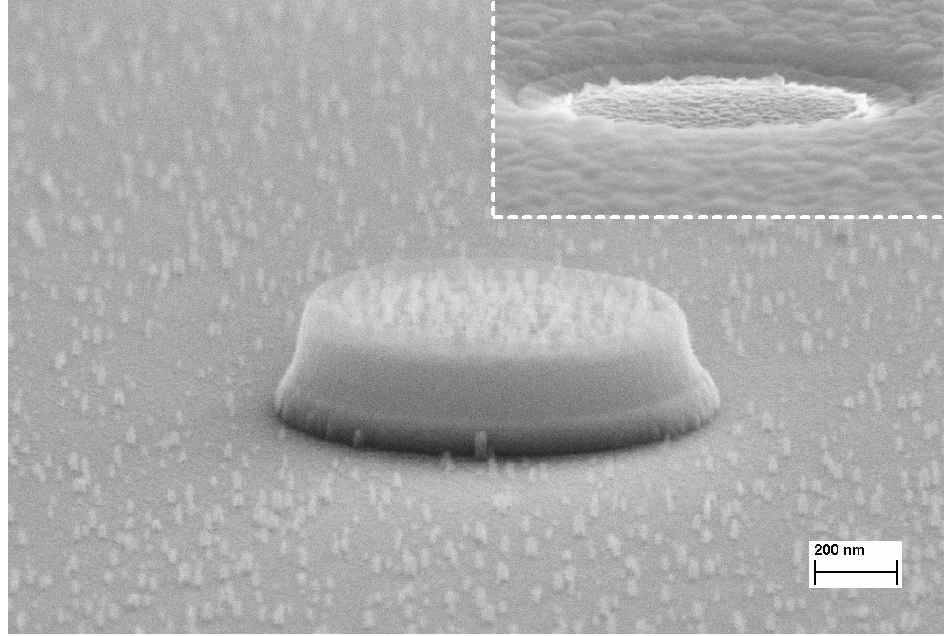
Figure 2. The ma-N 2400 resist film with a diameter of 1 µm, exposed at a dose of 275 µC/cm 2 after plasma chemical etching in an SF 6 atmosphere. The diameter of the NbN layer of the three-layer structure is 1.02 µm corresponding to the planned size. Inset in the upper-right corner: tunnel junction after applying SiO 2 insulation and liftoff.